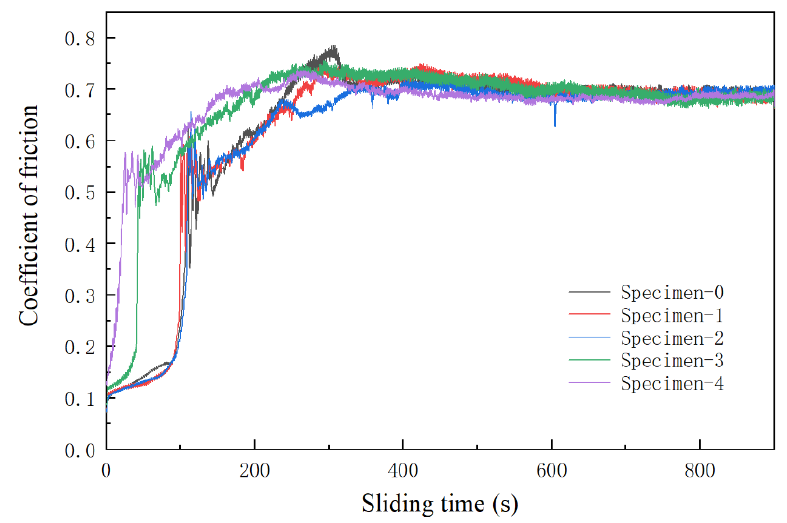
Figure 9. The coefficient of friction of AM